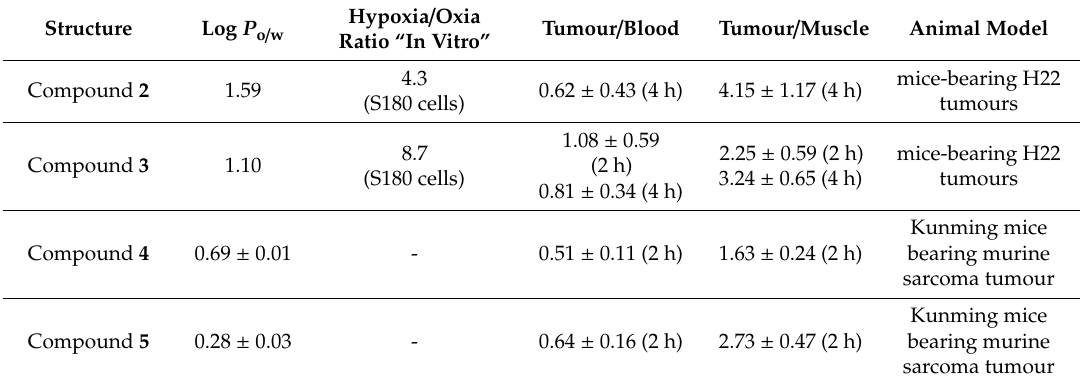
Table 2. Comparison of “in vitro” and “in vivo” uptake of [ 99m Tc]Tc complexes bearing one or